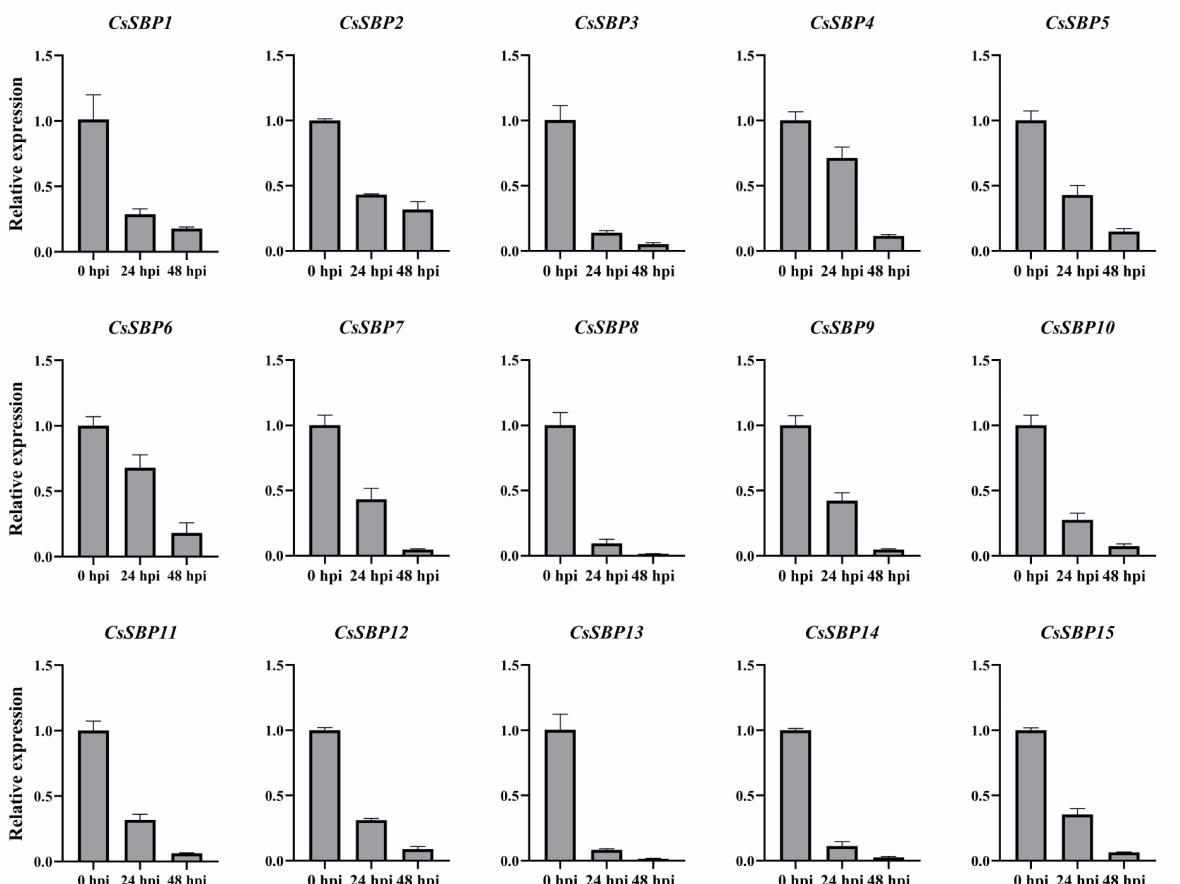
Figure 9. Expression levels of CsSBP genes inoculated with Diaporthe citri . The Y-axis indicates the relative expression level; X-axis (0, 24, and 48 hpi) indicated hours post D. citri inoculation. The standard errors are plotted using vertical lines. The experiments in all panels were repeated three times with similar